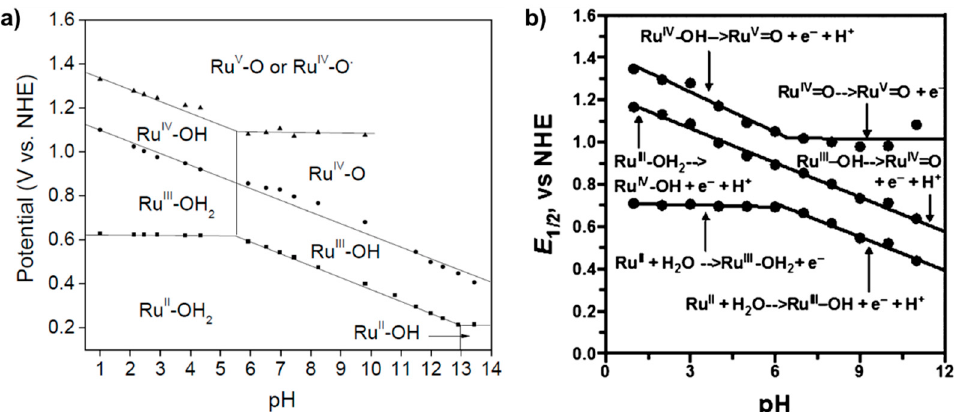
Figure 15. ( a ) Pourbaix diagram of 27 constructed by Sun’s group. Reprinted by permission